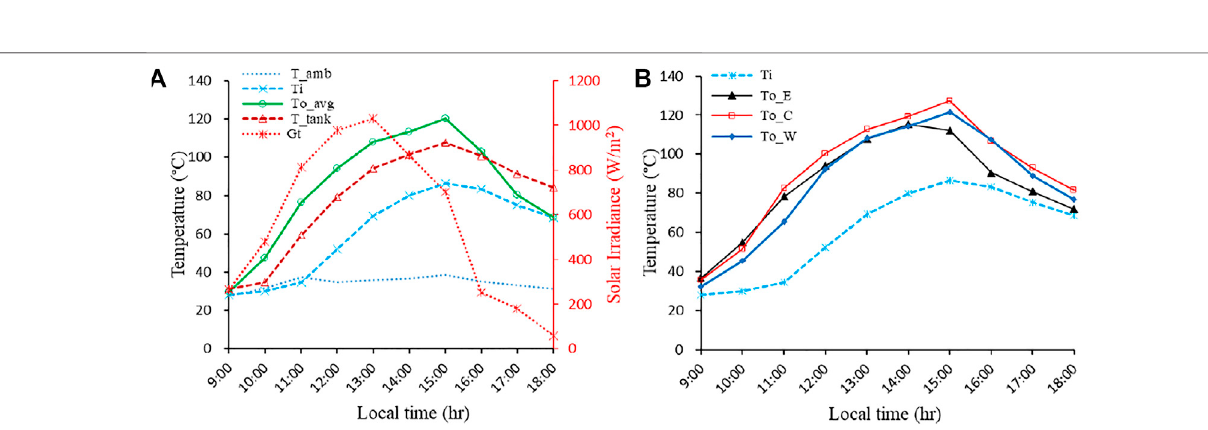
Frontiers in Energy Research |